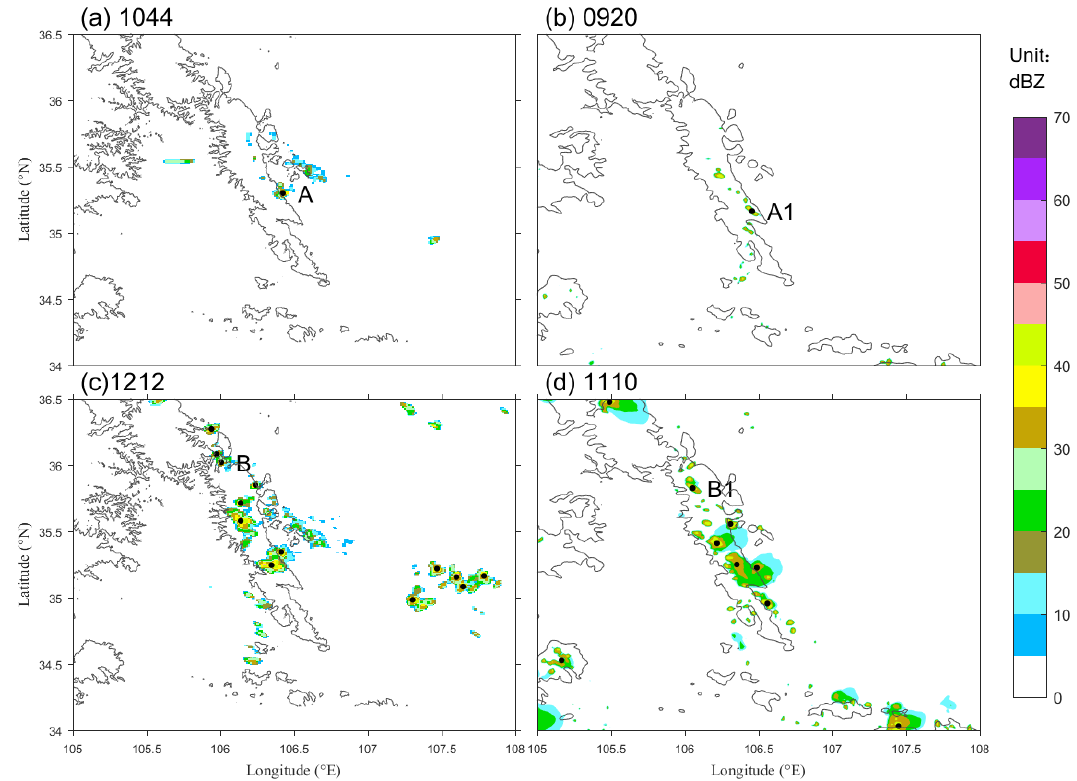
Figure 4. Observed ( a , c ) and simulated ( b , d ) radar composite reflectivity (shaded, units: dBZ) and CI point (black dots), ( a ) 1044, ( b ) 0920, ( c ) 1212, and ( d ) 1110 LST. The solid black lines are the 2000 m terrain contours.